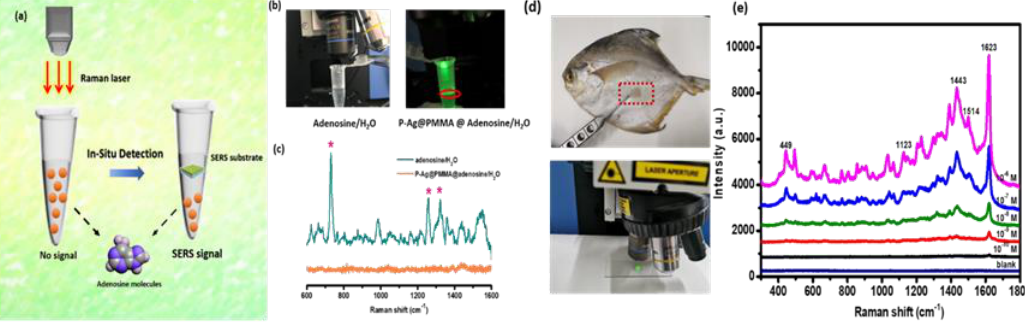
Figure 8. ( a ) Schematic illustration showing the in-situ detection process of the adenosine solution; ( b ) the optical picture of the in-situ detection of adenosine molecules; ( c ) Raman spectra of adenosine molecules before (orange line) and after (green line) placing the P–AgNPs@PMMA substrate on the adenosine solution to confirm the SERS effect. Insert: in-situ detection of adenosine molecule; ( d ) the optical picture of detecting of methylene-blue (MB) by swabbing the marine fish surface; ( e ) SERS spectra of MB obtained by swabbing fingerprint on the marine fish surface.